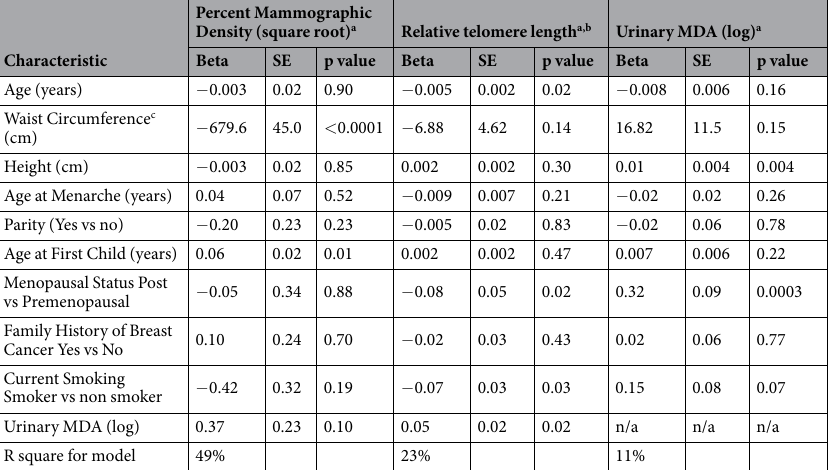
Table 2. Factors associated with percent mammographic density, relative telomere length and urinary MDA (multiple regression; n = 305). MDA = malondialdehyde; RTL = relative telomere length; SE = standard error; n/a = not applicable. a Outcome measure for regression analysis. b Adjusted for batch of PCR analysis; c Negative inverse transformed.